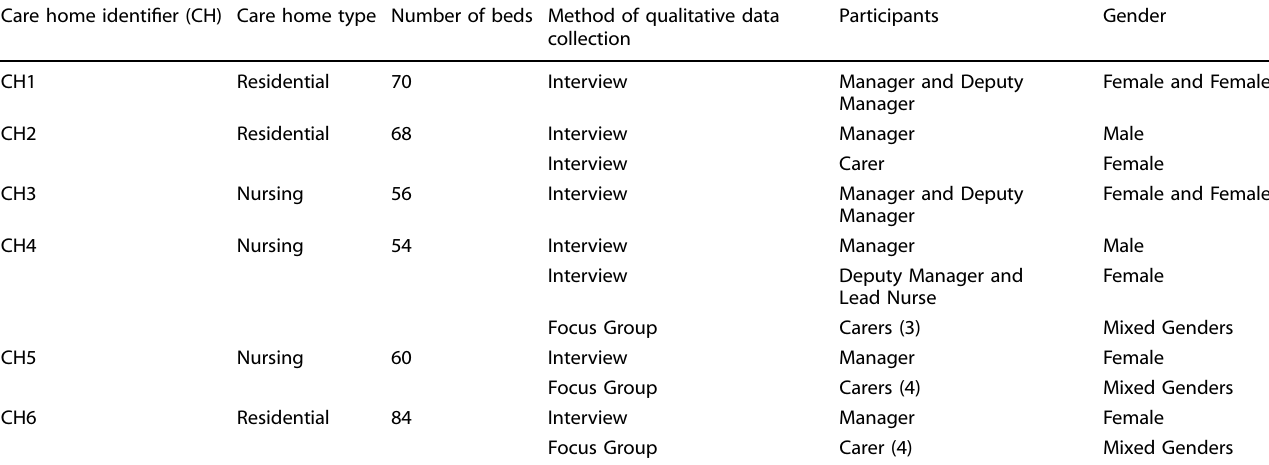
Table 1. Information on care homes and interviewee participants in the FInCH